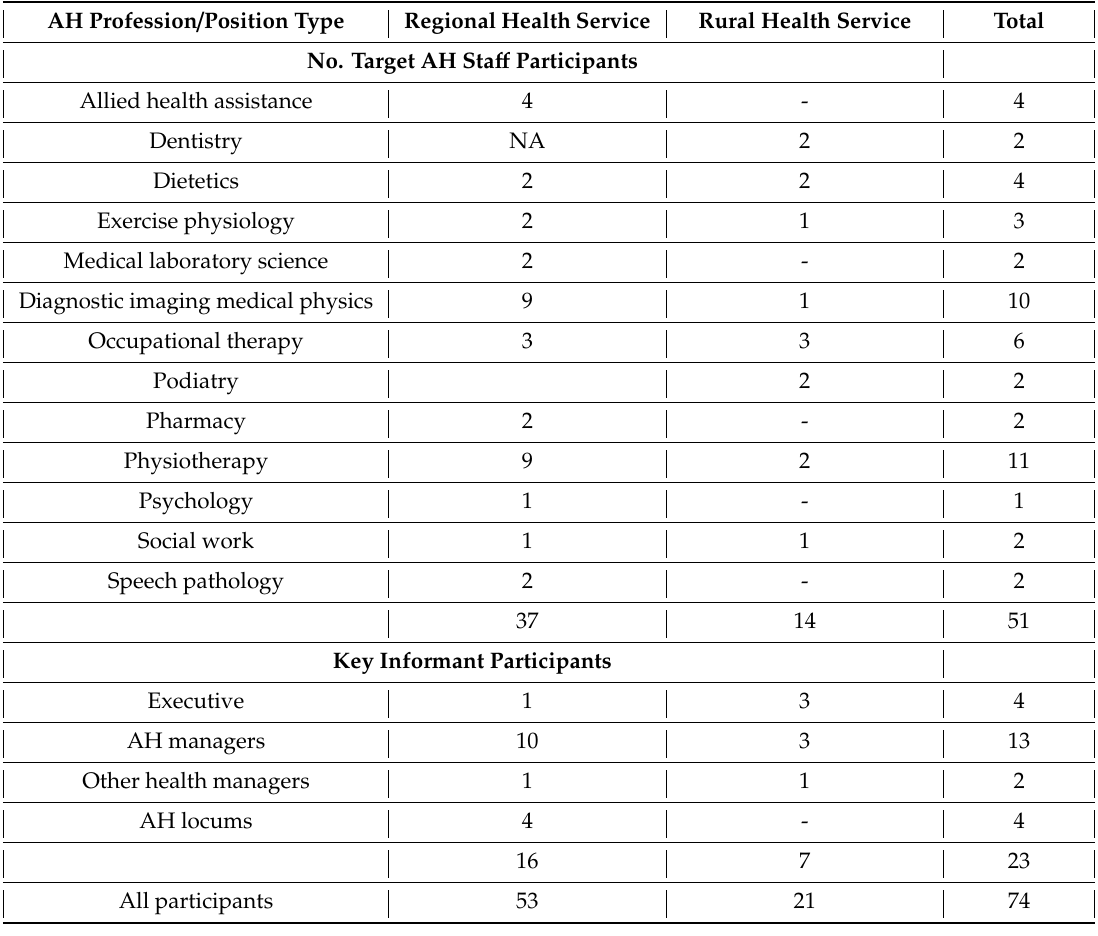
Table 2. Overview of participants by AH profession or position